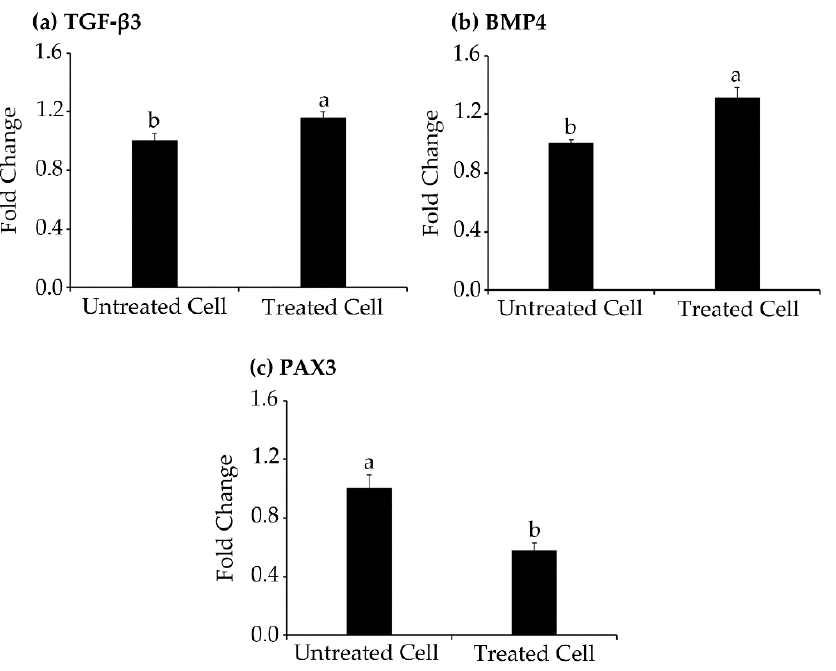
Figure 10. Gene expression. The effect of TILI-2 (350 µM) on the cellular mRNA for TGF- β 3 ( a ), BMP4 ( b ), and PAX3 ( c ) in B16F1 cells. All values represent the mean ± SD. Different letters indicate the significant differences from Duncan’s test ( p < 0.05).